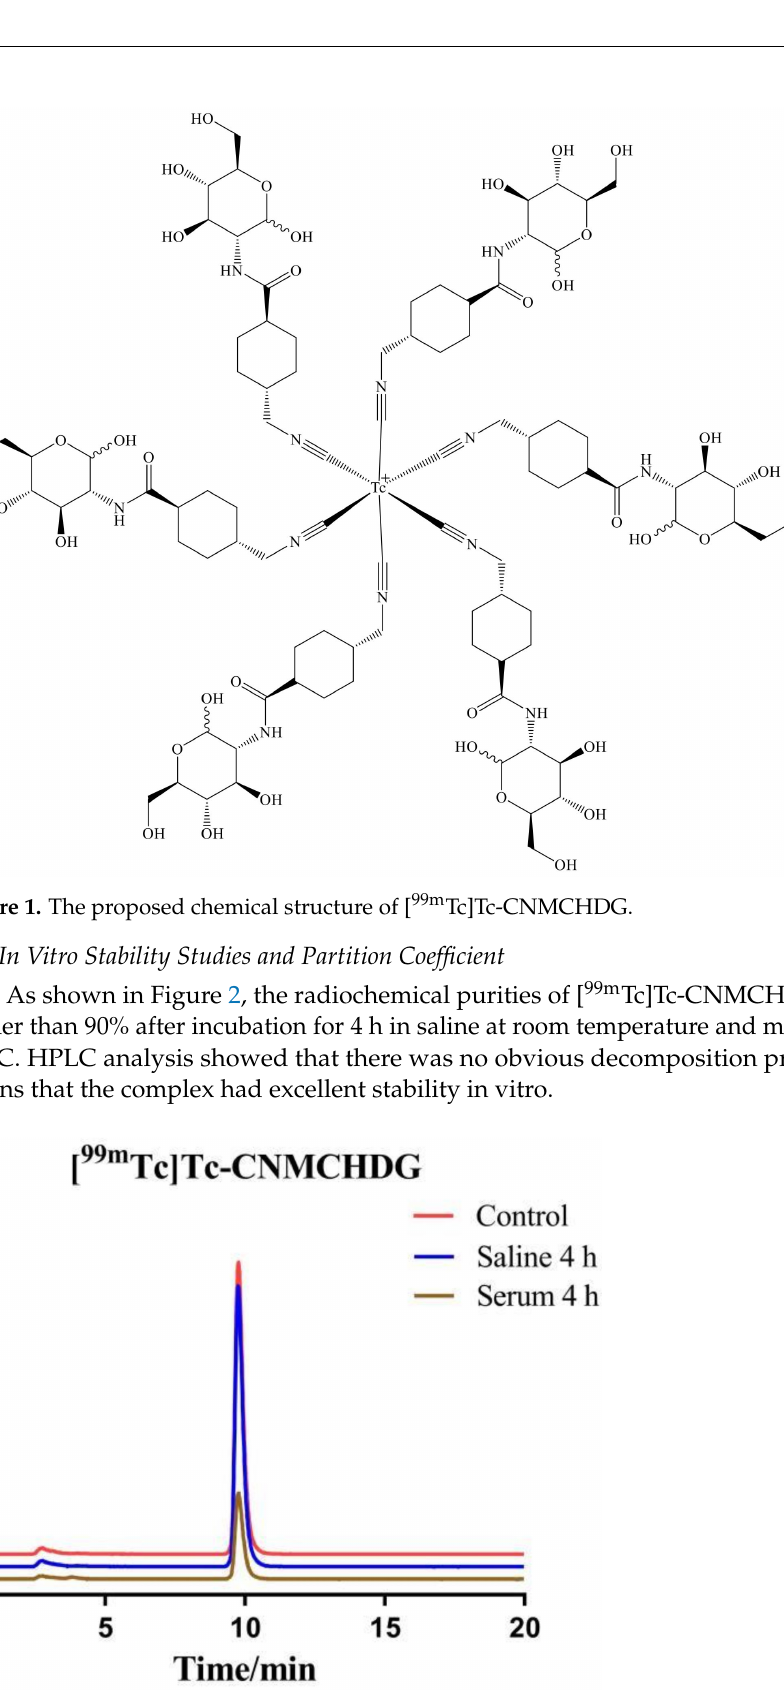
Figure 2. Radiochromatograms of [ 99m Tc]Tc-CNMCHDG in the original labeling solution (red line), and after incubation for 4 h in saline at room temperature (blue line) and mouse serum at 37 ◦ C (brown